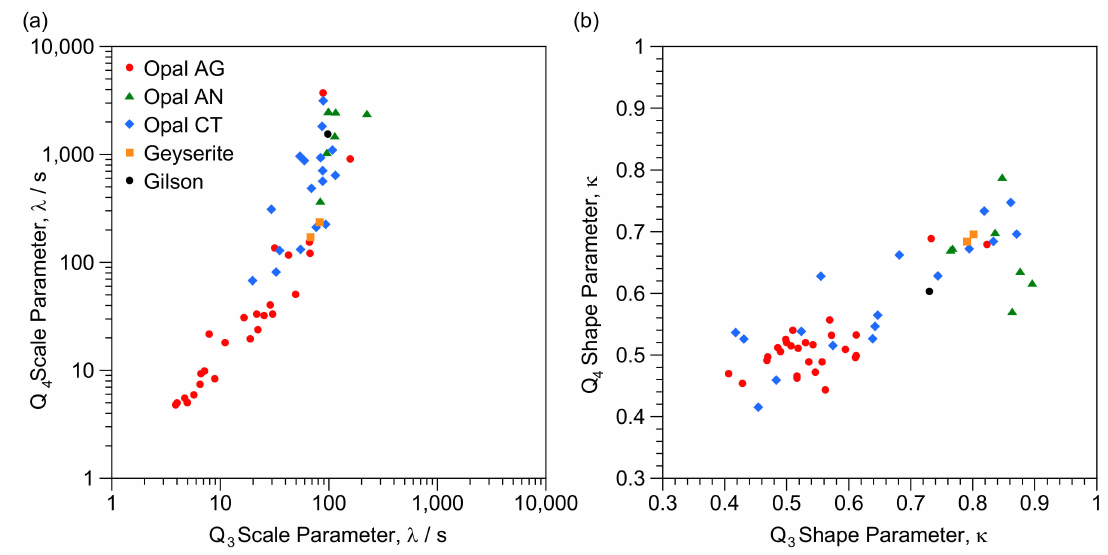
Figure 5. Correlation of scale and shape parameters for ( a ) Q 3 and Q 4 scale parameters ( b ) Q 3 and Q 4 shape parameters and designated with opal